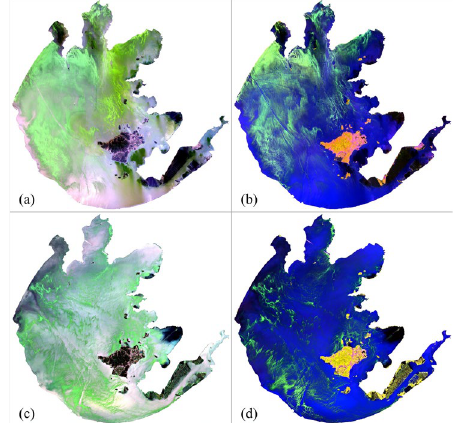
Figure 1. Satellite photograph of CBs in Lake Taihu (CHINA). True color images left and false color images right. The characteristic green colors of CBs are visible in ( a , b ) OLI images (11 May 2017) and ( c , d ) MSI images (17 August 2019).